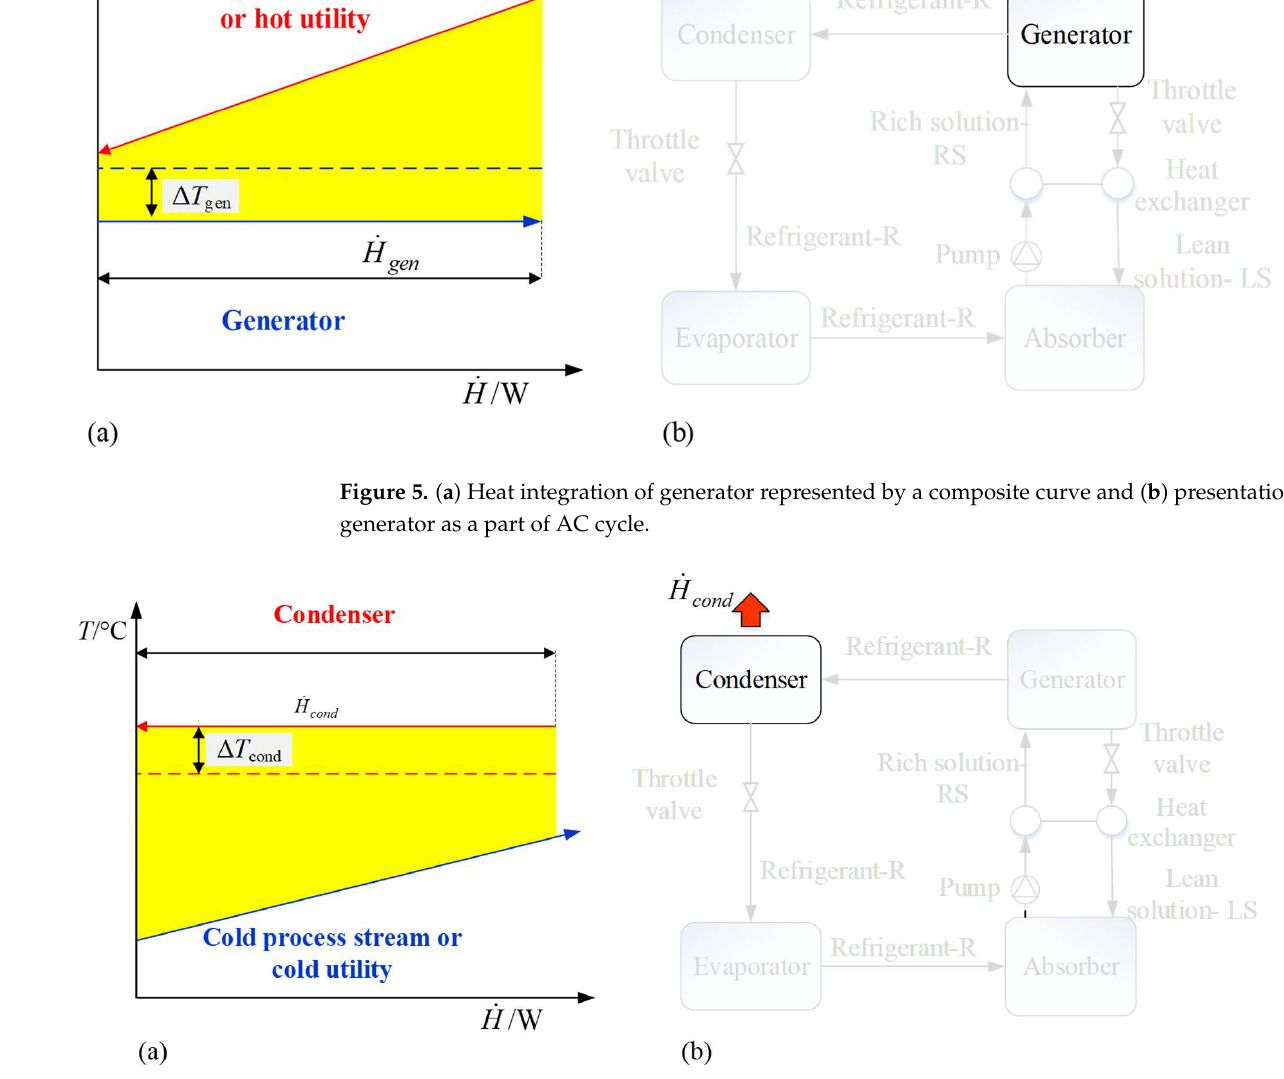
Figure 6. ( a ) Heat integration of a condenser by a composite curve and ( b ) presentation of condenser as a part of AC cycle.